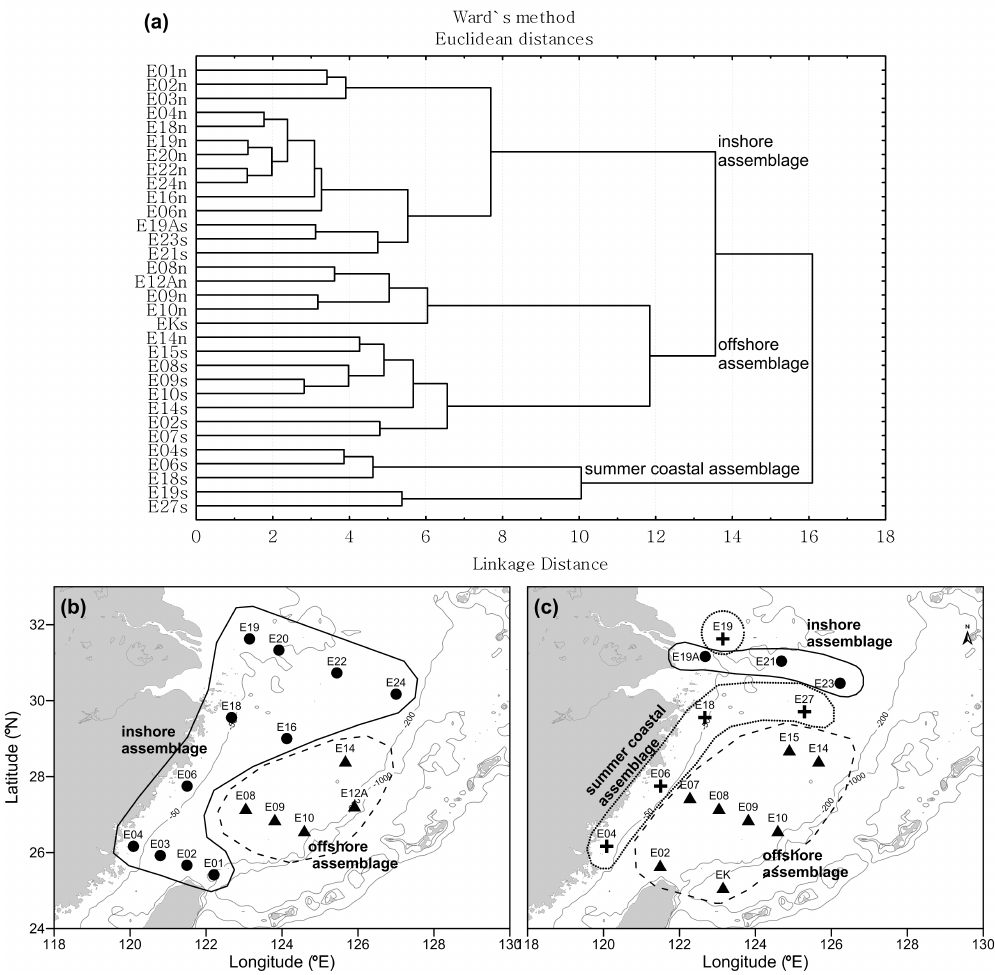
Fig. 8. The dendrogram of species composition similarity among stations (E; n , in the northeasterly monsoon season; s, in the southwesterly monsoon season) by Ward’s linkage cluster analysis (a) and its geographic locations of the larval fish assemblages in the northeasterly monsoon season (b) and the southwesterly monsoon season (c) (solids circles, inshore assemblage; solid triangles, offshore assemblage; crosses, summer coastal